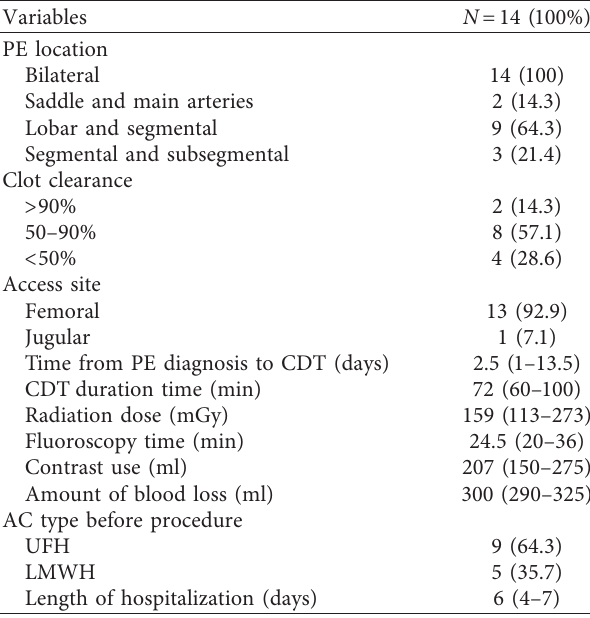
Table 1: Detailed clinical and outcomes characteristics. Table 2: The CDT procedure